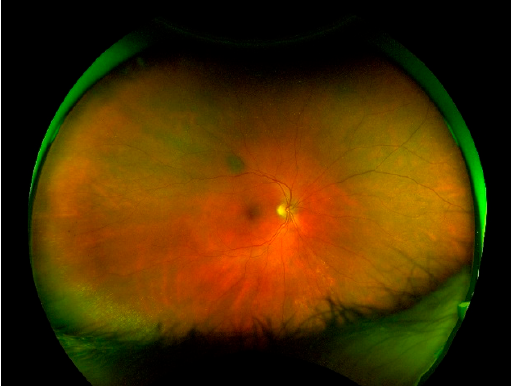
Figure 1. Color image of the fundus obtained using ultra-wide field laser scanning ophthalmoscopy in a patient with epiretinal membrane and exhibiting benign peripheral lesions of the retina and choroidal nevus.